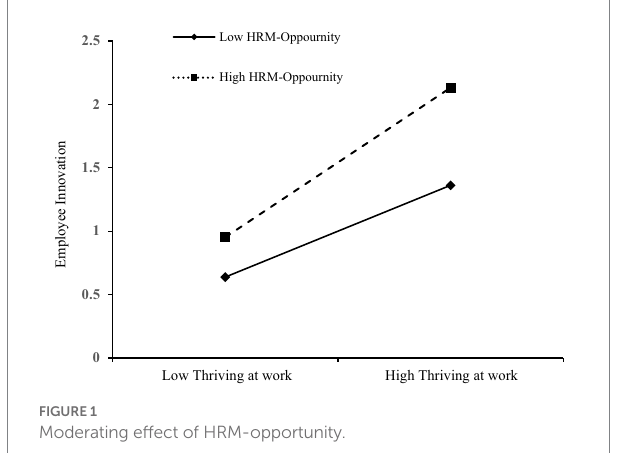
FIGURE 1 Moderating effect of